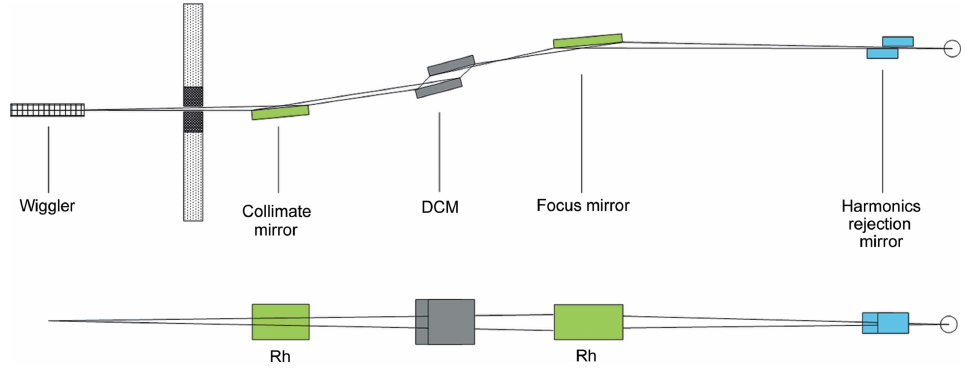
Figure 1 Schematic of the XAFS beamline in focused